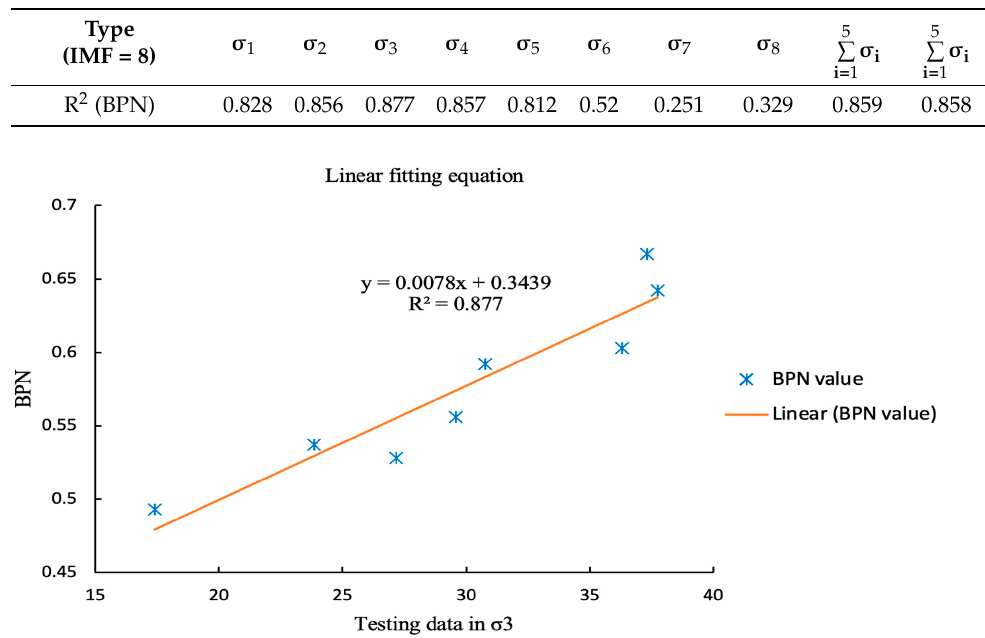
Table 1. R 2 goodness of fit.